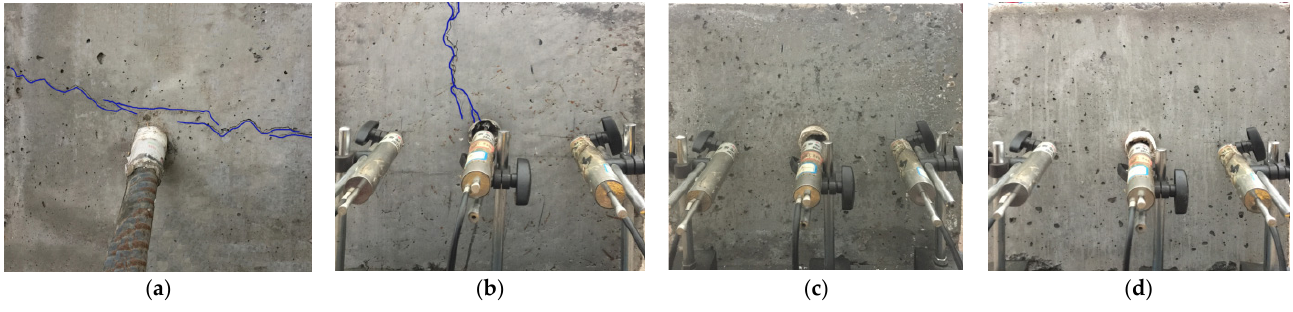
Figure 4. Failure modes of tested specimens: ( a ) v f = 0%; ( b ) v f = 0.8%; ( c ) v f = 1.2%; ( d ) v f =